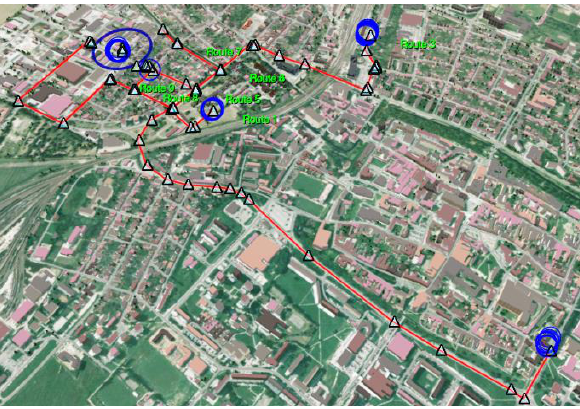
Figure 1. Visualization of the simulation in map